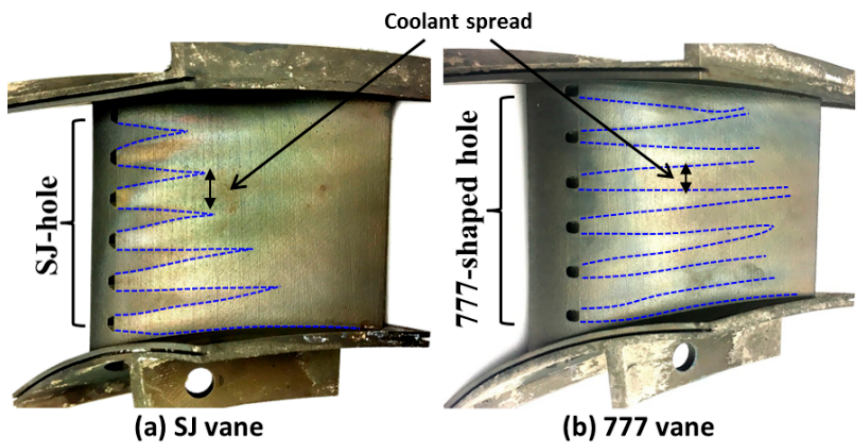
Figure 24. Synthetic jet hole coverage is much better than 777 film hole-pattern as reported by Hossain [130]. More discussion available in Hossain et al. [132].